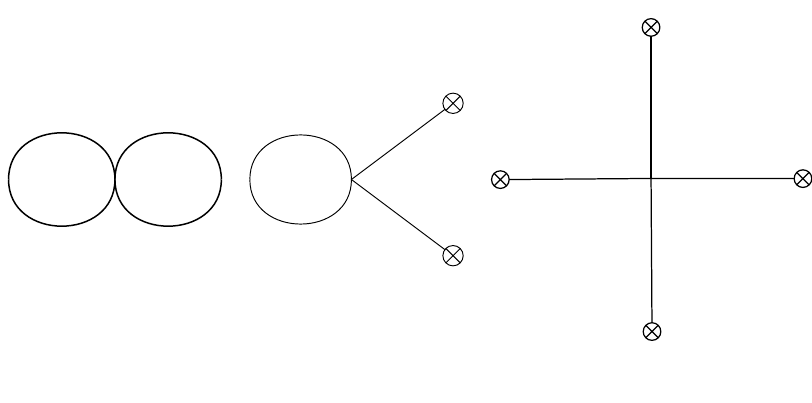
Figure 2 . Diagrams contributing to the statistical prefactor at